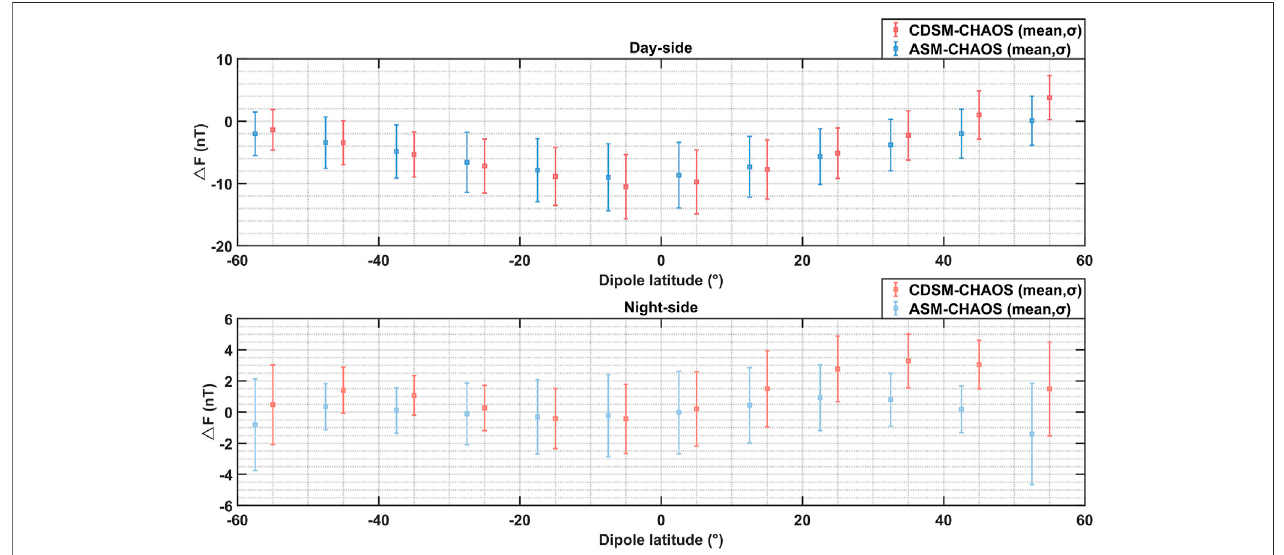
FIGURE 7 | Error bars of Δ F of the CDSM and ASM using selected data from July 31 to 30 September 2019 are similar (the error bars of Swarm Bravo have been shifted 2.5 ° horizontally to the left in order to allow a visual comparison).